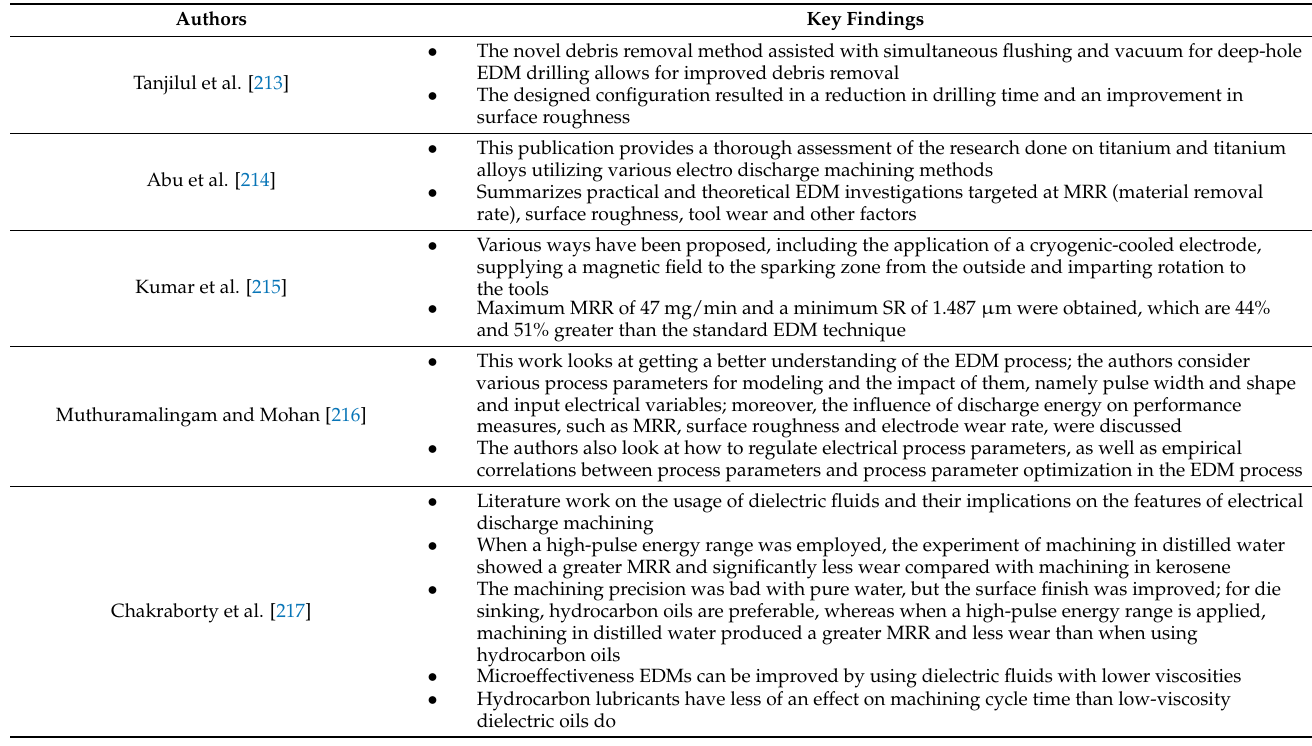
Figure 10. Surface layers after EDM treatment. Table 15. Key findings of research on the theme of EDM.